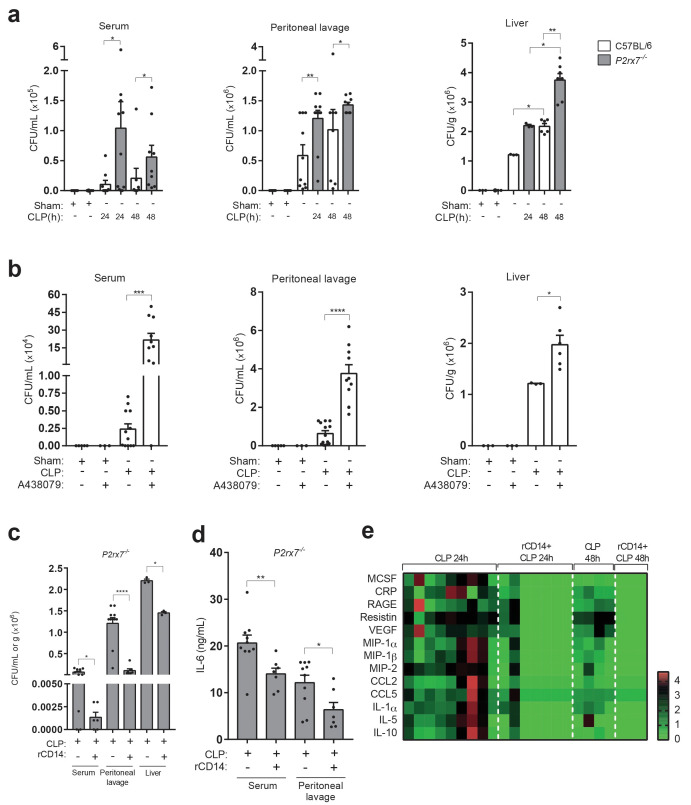
Extracellular CD14 limits bacterial dissemination and cytokine production during sepsis caused by P2X7 receptor deficiency.(a) Bacterial load in serum, peritoneal lavage and liver homogenates from C57BL/6 (wild-type) and P2rx7−/− mice collected 24 and 48 hr after CLP. (b) Bacterial load in serum, peritoneal lavage, and liver homogenates from C57BL/6 (wild-type) mice treated with A438074 (100 µM/kg) and collected 24 hr after CLP. (c) Bacterial load in serum, peritoneal lavage and liver from P2rx7−/− mice treated with recombinant CD14 (rCD14, 10 µg/g) 30 min before CLP and collected 24 hr after CLP. (d) ELISA for IL-6 in serum and peritoneal lavage samples from P2rx7−/− mice collected 24 hr after CLP with or without treatment with recombinant CD14 (rCD14, 10 µg/g) 30 min before CLP; each dot represents a single mouse and data are represented as mean ± SEM. (e) Heatmaps for the concentrations of different cytokines, chemokines and acute phase proteins as indicated in the serum of P2rx7−/−mice treated with rCD14 as in (d) collected 24 and 48 hr after CLP. For a-d panels, each dot represents a single mouse and data are represented as mean ± SEM; *p<0.05; **p<0.01; ***p<0.001; ****p<0.0001; Mann-Whitney test.Figure 5—source data 1.Source data file for Figure 5.